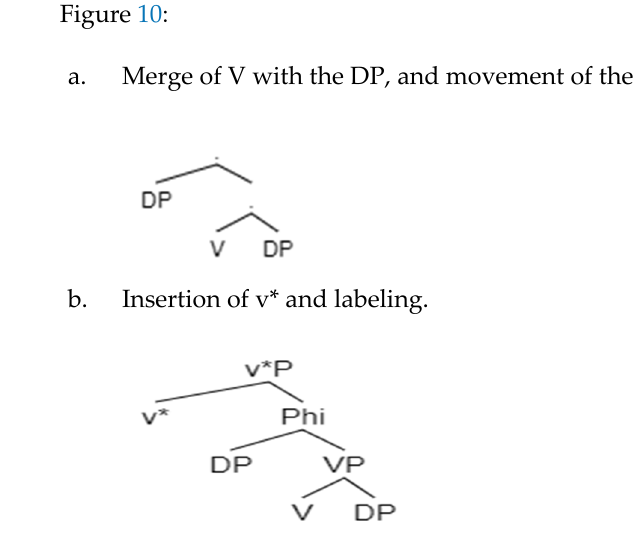
b. Insertion of v* and labeling.